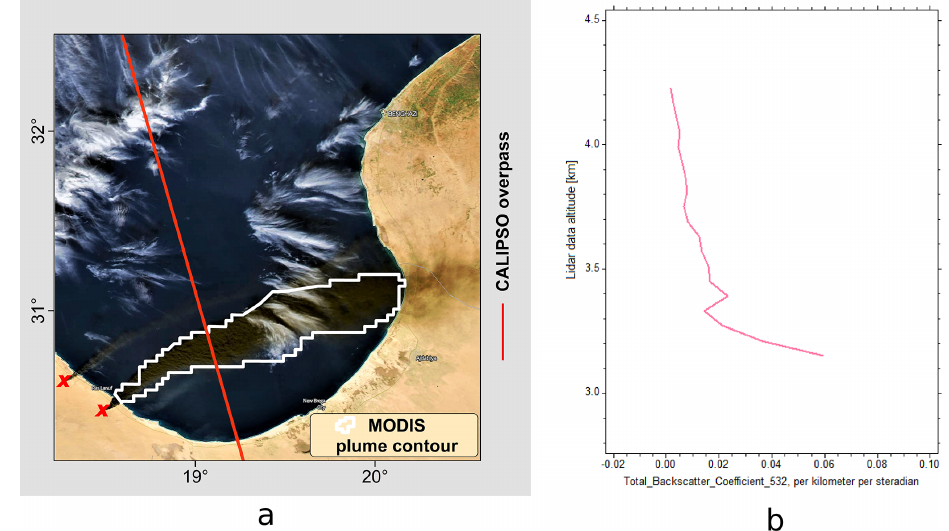
Figure 4. (a) CALIPSO overpass and MODIS plume contour 7. (b) Particulate backscatter coefficient profile CALIPSO level 2 (532nm) (satellite imagery from the NASA Worldview application, https://worldview.earthdata.nasa.gov, last access: 5 January